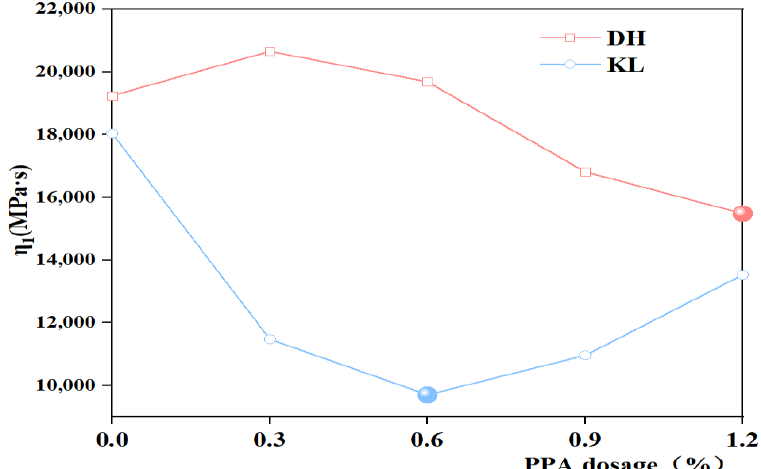
Figure 12. The η 1 value of single modified asphalt with different PPA dosages.